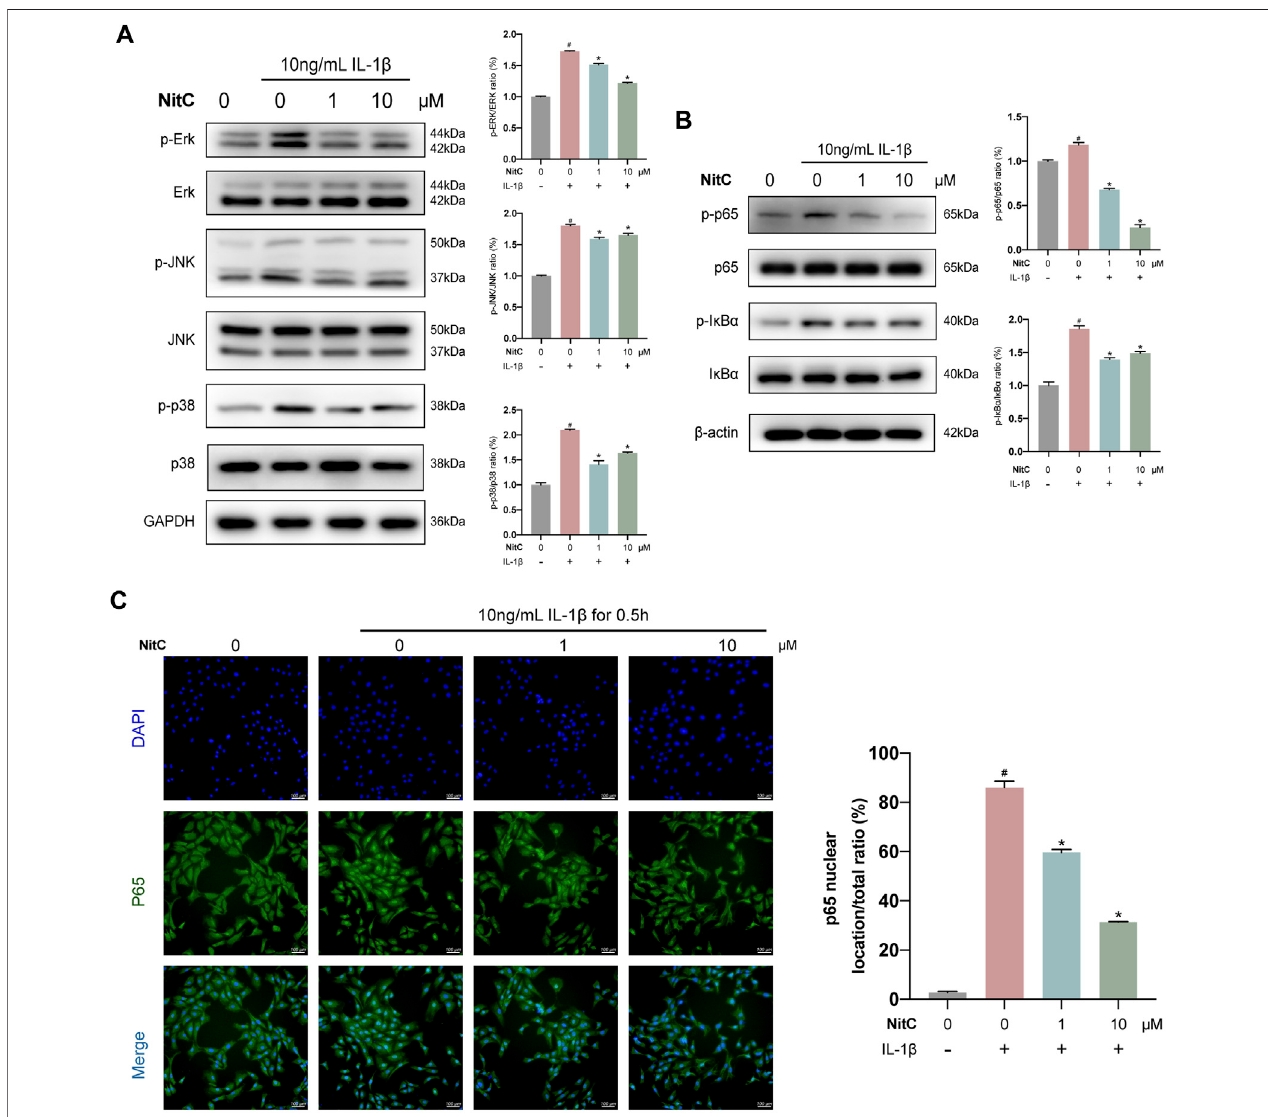
FIGURE 3 | NitC inhibited MAPK and NF- κ B pathway in the osteoarthritic model in vitro . (A) The WB analysis of MAPK pathway-related protein: p-ERK, ERK, p-JNK, JNK, p-p38, and p38 as well as endogenous control GA were performed as previously described. Besides, the p-ERK/ERK, p-JNK/JNK, and p-p38/p38 ratios were shown. (B) The WB analysis of NF- κ B pathway-related protein: p-p65, p65, p-I κ B α , I κ B α , and endogenous control β -Actin were conducted. The p-p65/p65 and p-I κ B α /I κ B α ratios were shown. (C) The nuclear translocation of p65 was assessed by immuno fl uorescent microscopy. The quanti fi ed results of nuclear